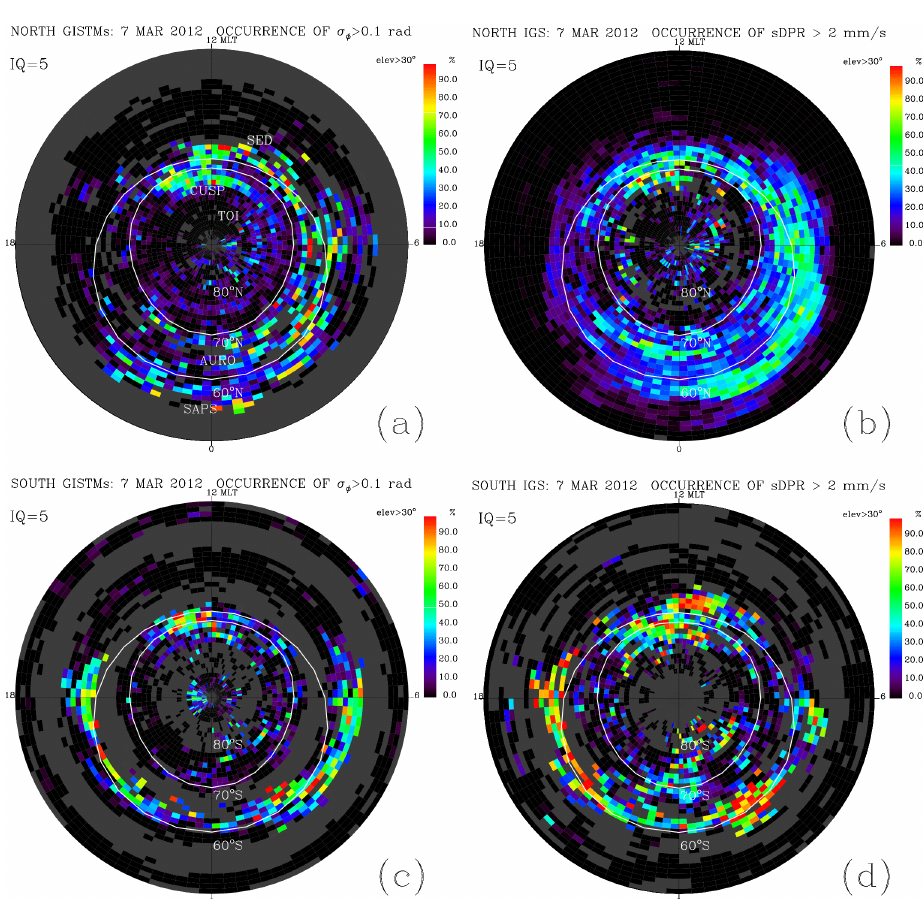
Figure 5. The phase scintillation occurrence of (a, c) σ (cid:56) >0.1rad and (b, d) sDPR>2mms − 1 in the coordinates of AACGM latitude vs. MLT for the northern (top panels) and southern (bottom panels) high latitudes on 7 March. The position of the statistical auroral oval (Feldstein and Starkov, 1967; Holzworth and Meng, 1975) for disturbed conditions (IQ = 5) is superposed. Five regions of scintillation (“CUSP”, “TOI”, ”AURO”, “SAPS” and “SED”) are approximately indicated in the first